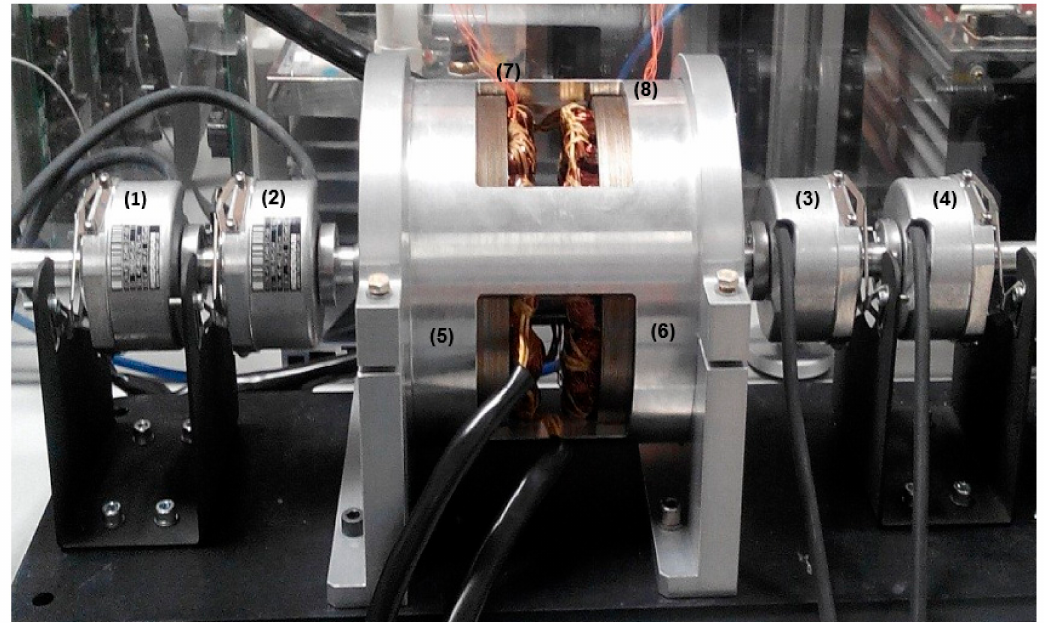
Figure 1. Full prototype of the designed actuator. ( 1 ), ( 2 ), ( 3 ), ( 4 ): position sensors; ( 5 ), ( 6 ): six-phase stators; ( 7 ), ( 8 ): temperature